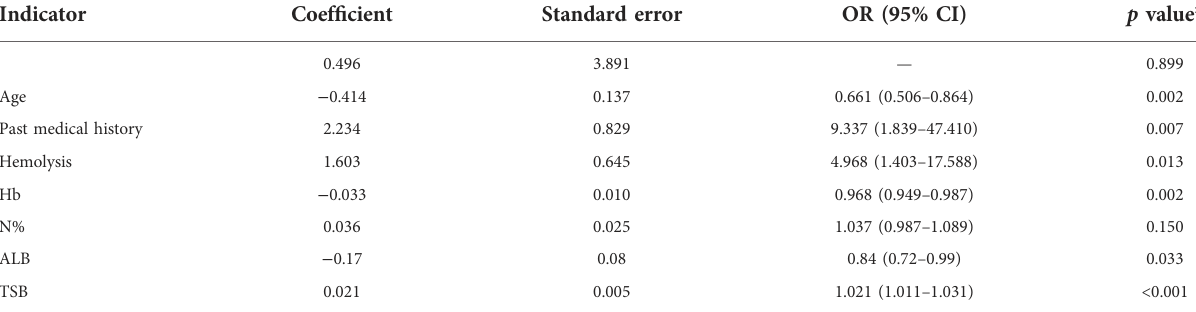
TABLE 4 Model 1 created with stepwise logistic regression analysis of seven admission